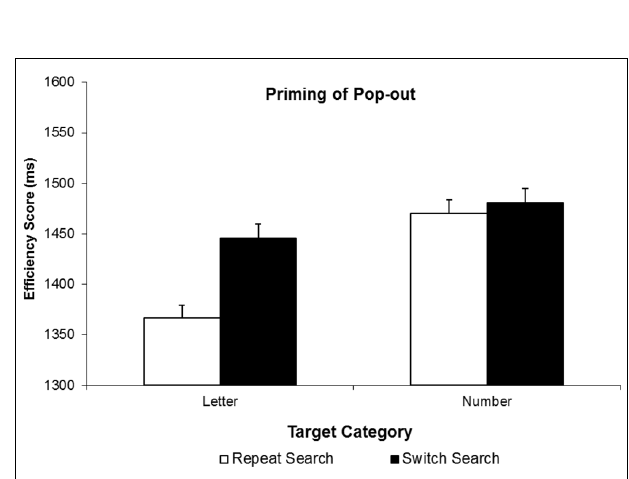
FIGURE 3 | Results of Experiment 2. Efficiency scores are plotted as a function of target type (letter or number) on the current trial and trial type: Repeat Search and Switch Search conditions, for Priming of Pop-out. Error bars indicate the standard error of the